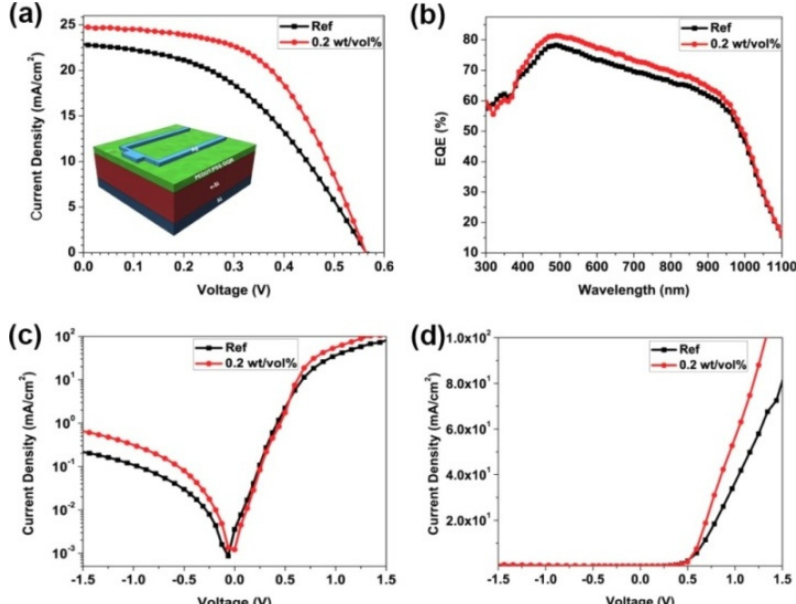
Figure 10. Characteristics of the fabricated device structure Ag/PEDOT:PSS/Si/Al with and without GQRs. ( a ) Current density versus voltage characteristics of reference and optimized device; inset image shows device structure. ( b ) External quantum efficiency (EQE). ( c ) Dark current for leakage. ( d ) Dark current. Reprinted with the permission of Reference [98]. Copyright 2015 American Chemical Society.